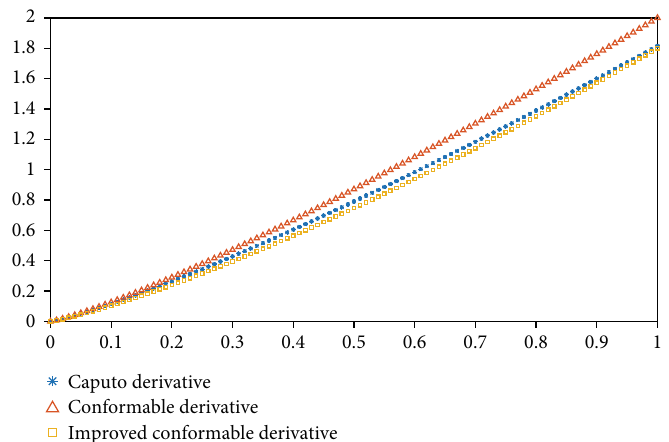
Figure 5: 0.8th fractional derivative of y = x 2 .